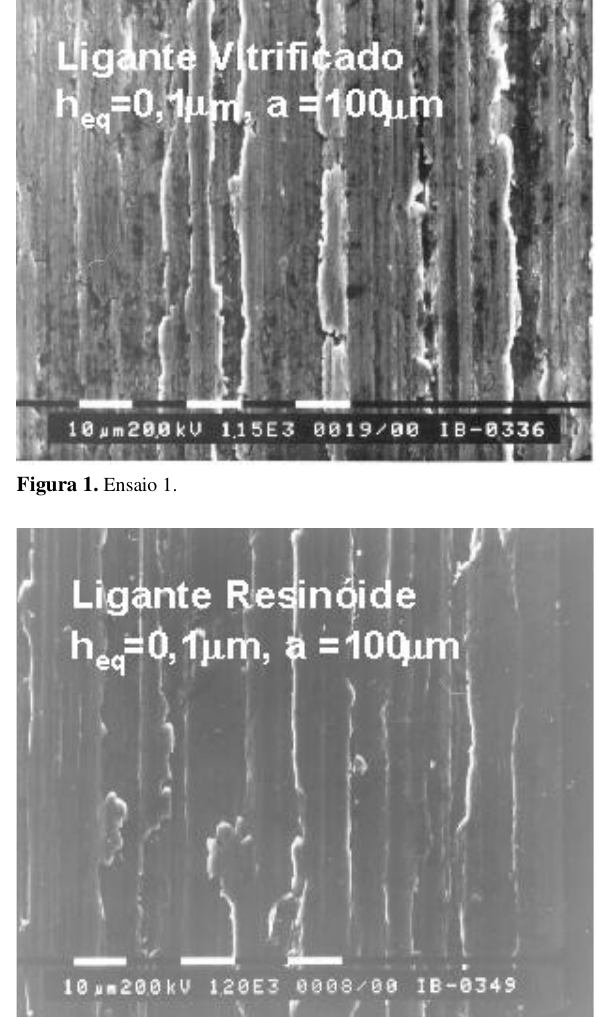
Figura 2. Ensaio 2. Figura 4. Ensaio 4.